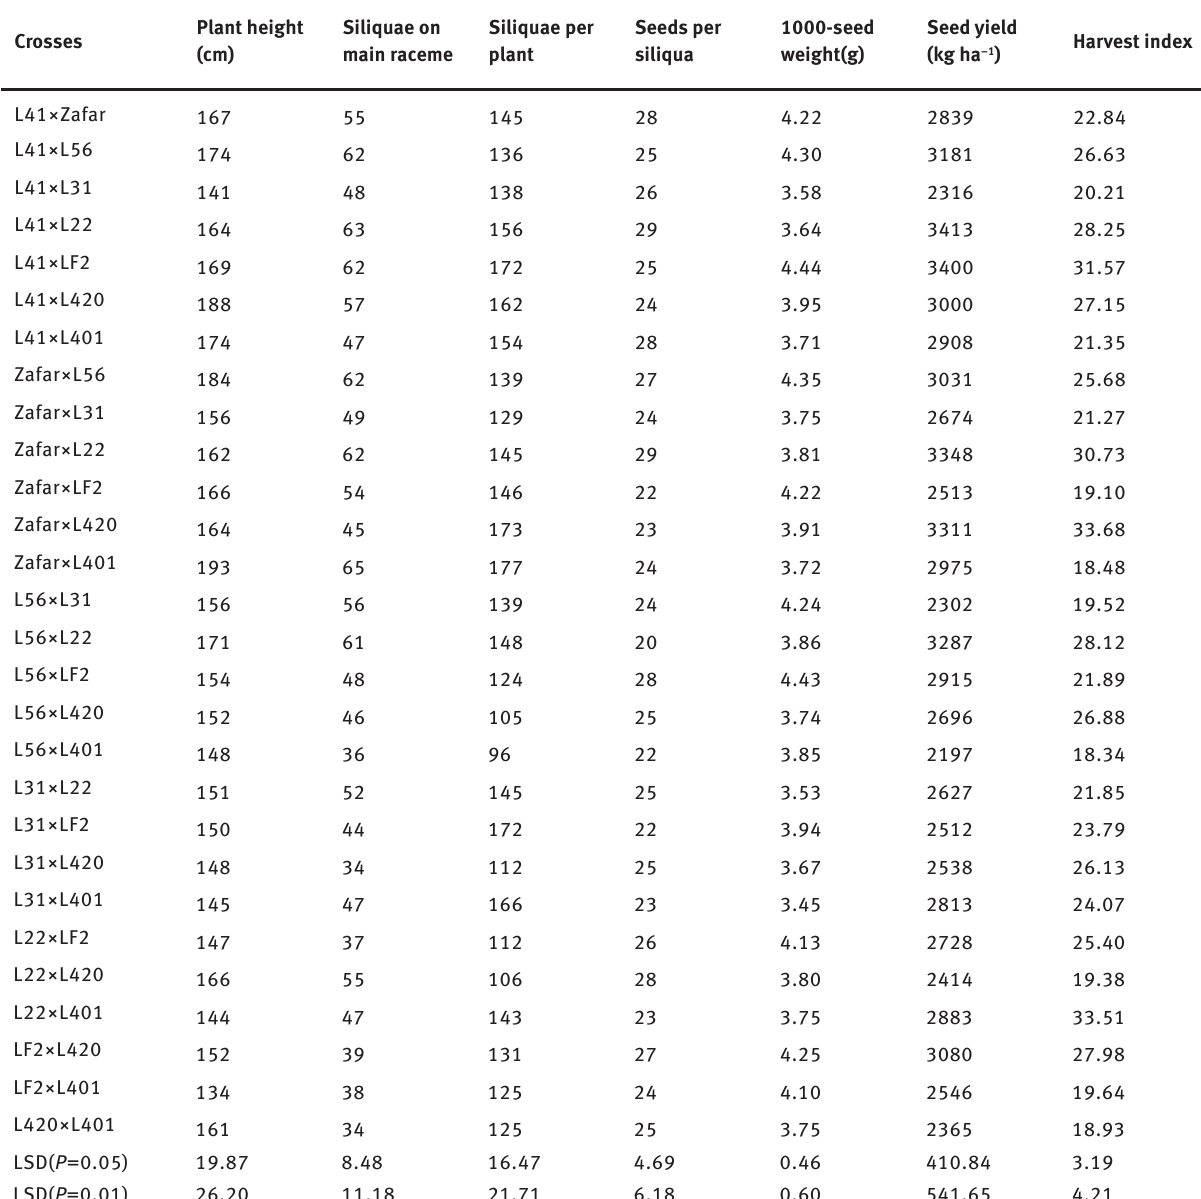
Table 3: Comparison of mean for yield components and seed yield in half diallel crosses of eight oilseed rape genotypes